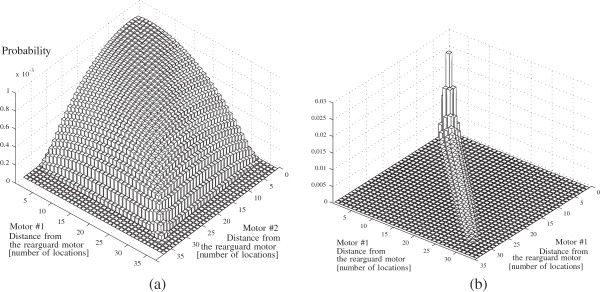
A representation of the steady state probability distributions Π  for an ensemble of three motors with low load (a) and high load on the cargo (b). The rear-guard motor is taken as a reference. The x and the y axes represent the distance of the other two motors from the rear-guard one. The distance is expressed in number of locations on the microtubule. The z axis represent the probability associated with a specific relative configuration. In the case of a low load, the motor proteins tend to be more spread out. Instead, in the case of a high load we observe that they tend to be clustered together or to prefer a configuration with two leading motors and the rear-guard lagging behind.